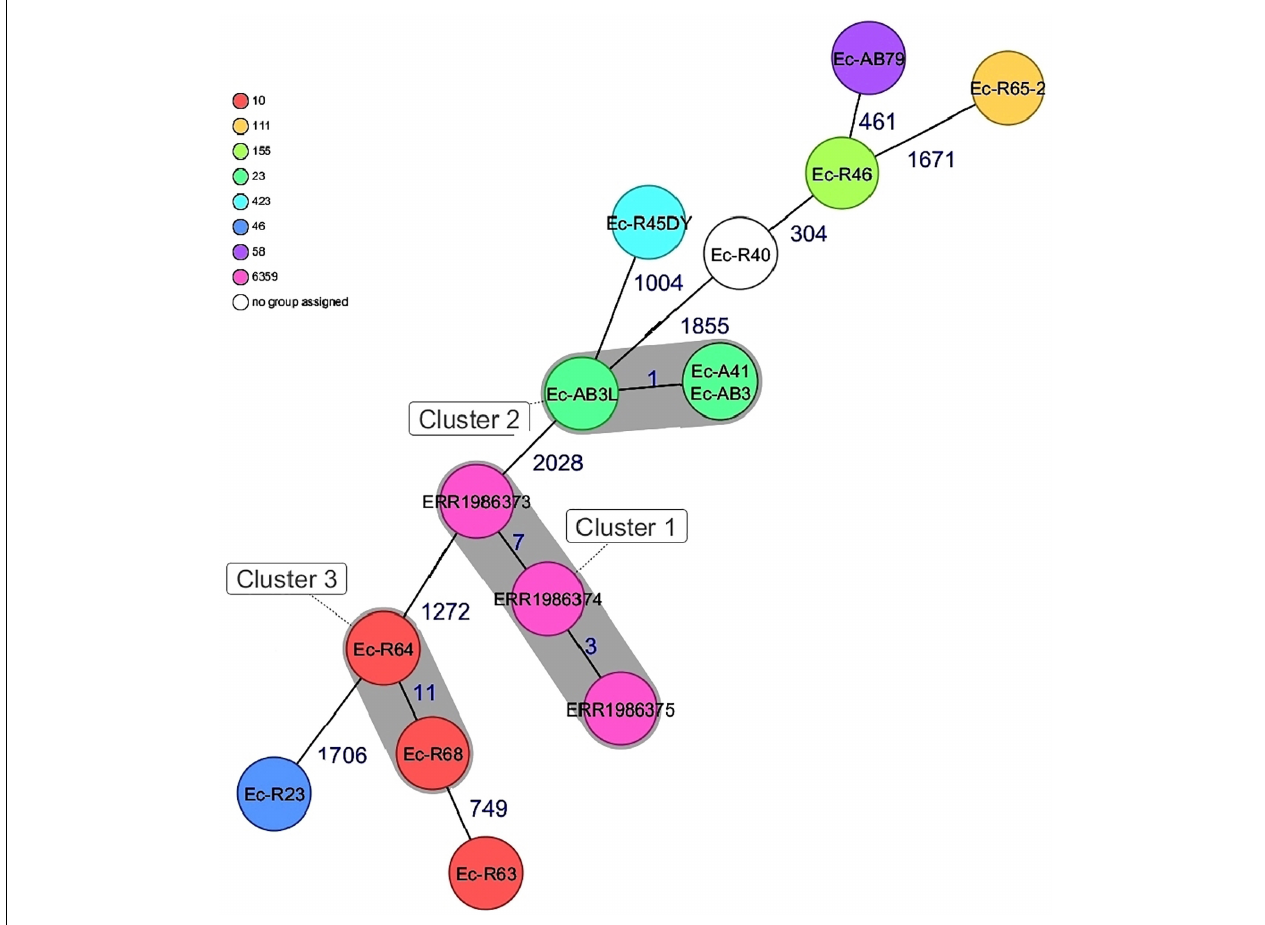
FIGURE 2 | Minimum spanning tree for 15 E. coli isolates based on cgMLST of E.coli . Colors corresponds to the sequence types of the isolates. Each circle represents isolates with an allelic profile based on the sequences of 2520 core genome targets. Isolates with closely related genotypes were identified with a maximum of 11 allelic differences and are shaded in